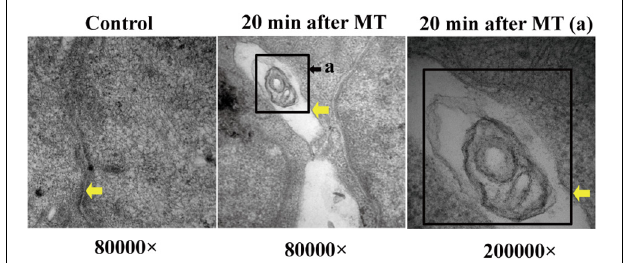
FIGURE 6 | Bacterial structure between cell junctions. The position of the yellow arrows were defined as the cell junction or bacterial structure in the gap. The black square showed the bacterial structure. (a) Enlarged picture under the same vision at 20 min after MT (200,000 ×